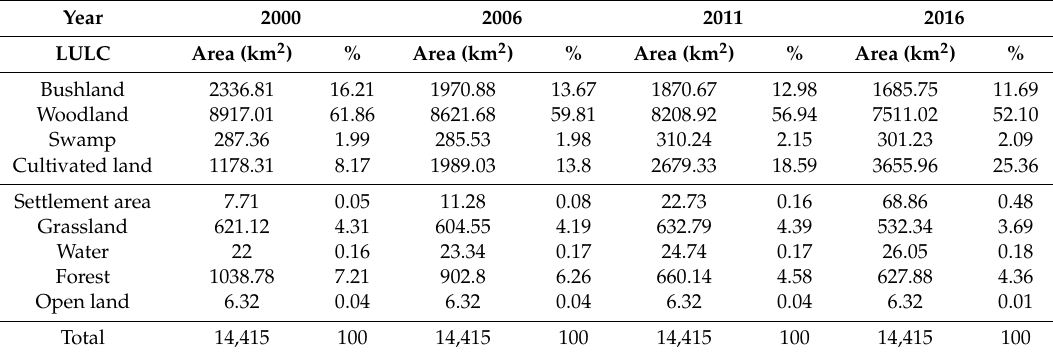
Table 8. Results of the LULC classification for 2000, 2006, 2011, and 2016 images showing the area of each category and category percentages (Wami Sub-catchment).